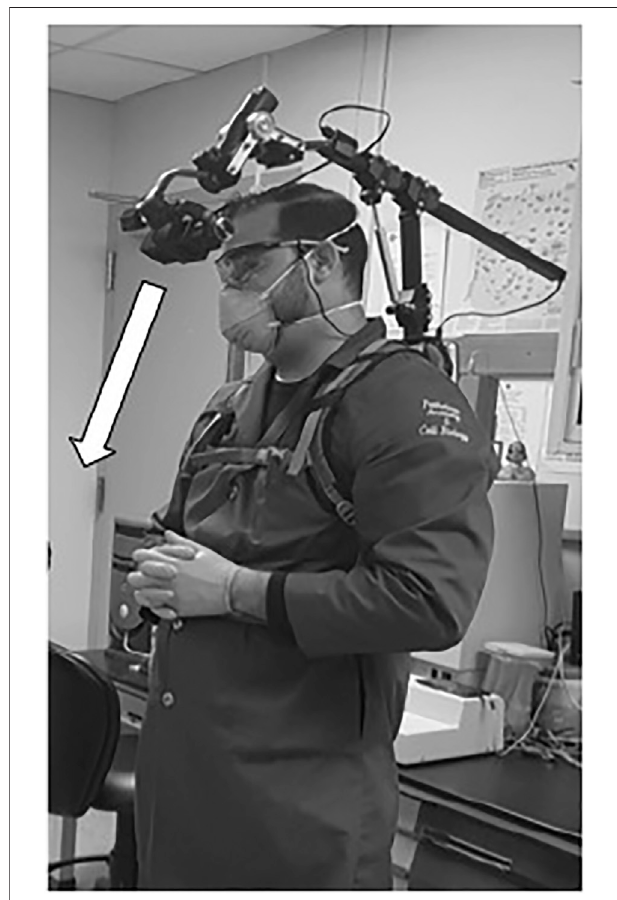
FIGURE 1 | Actual fi rst person point-of-view (FPV) perspective of the neuroscientist LSN (i.e., white arrow) wearing the point-of-view recording device technology setup (Ros and Trives, 2020). The stereotaxic surgery was recorded from this perspective and then integrated into the Revinax Handbook to be displayed in both the 180 ° video VR HMD and the 3D video computer display formats for the present study. LSN consented to having his picture taken to demonstrate the